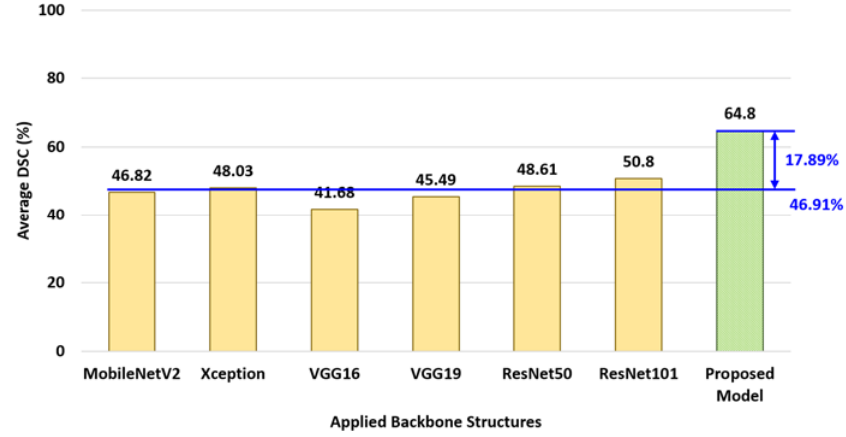
Figure 20. Comparing the proposed approach with 6 other backbone networks.